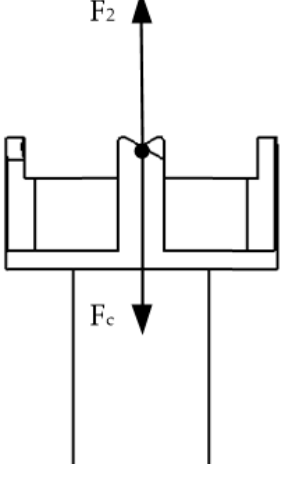
Figure 15. Force relationship of the cylindrical top rod.